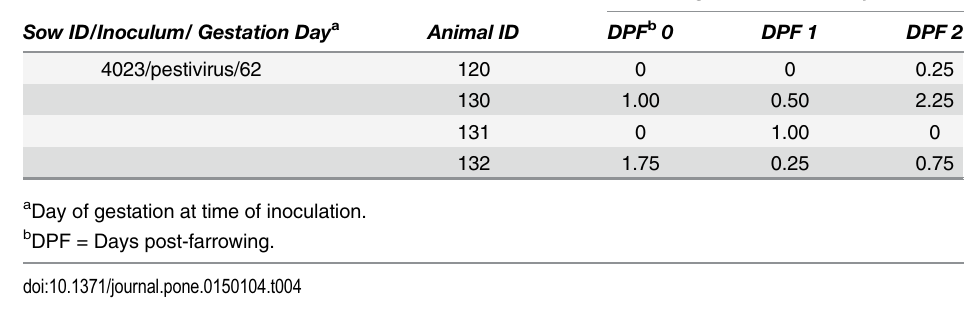
PLOS ONE | DOI:10.1371/journal.pone.0150104 February 24,